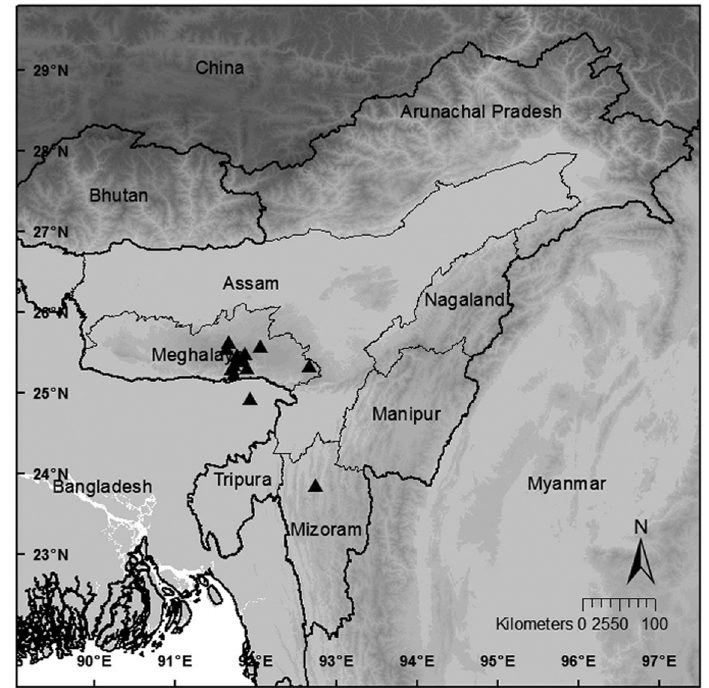
Fig. 46. Map showing the location of B. pedunculosa